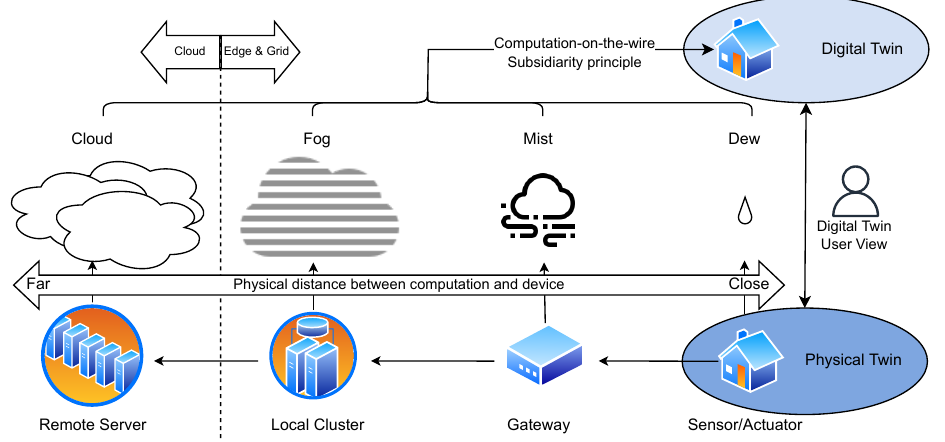
Figure 13. Computing Hydrology of computation-on-the-wire . Computing power can be located locally at the sensor/actuator or more remotely at the gateway, a local cluster, or remote server. The computations form the basis for a DT. Computing in IoT and Smart Cities is often conceptualised with hydrological terminology (i.e., cloud, fog, mist, and dew) that maps to the computing location and encapsulates different trade-offs in computational intensity, traffic, latency, accuracy, energy consumption, and security [42,191]. These trade-offs are best evaluated under the subsidiarity principle to decide where to place the computation physically. Edge or grid computing [150,151] is another terminology to cover all non-cloud computing. DTs rely heavily on these different data and computing sources while at the same time abstracting away their existence in the end users’ view. Generated with